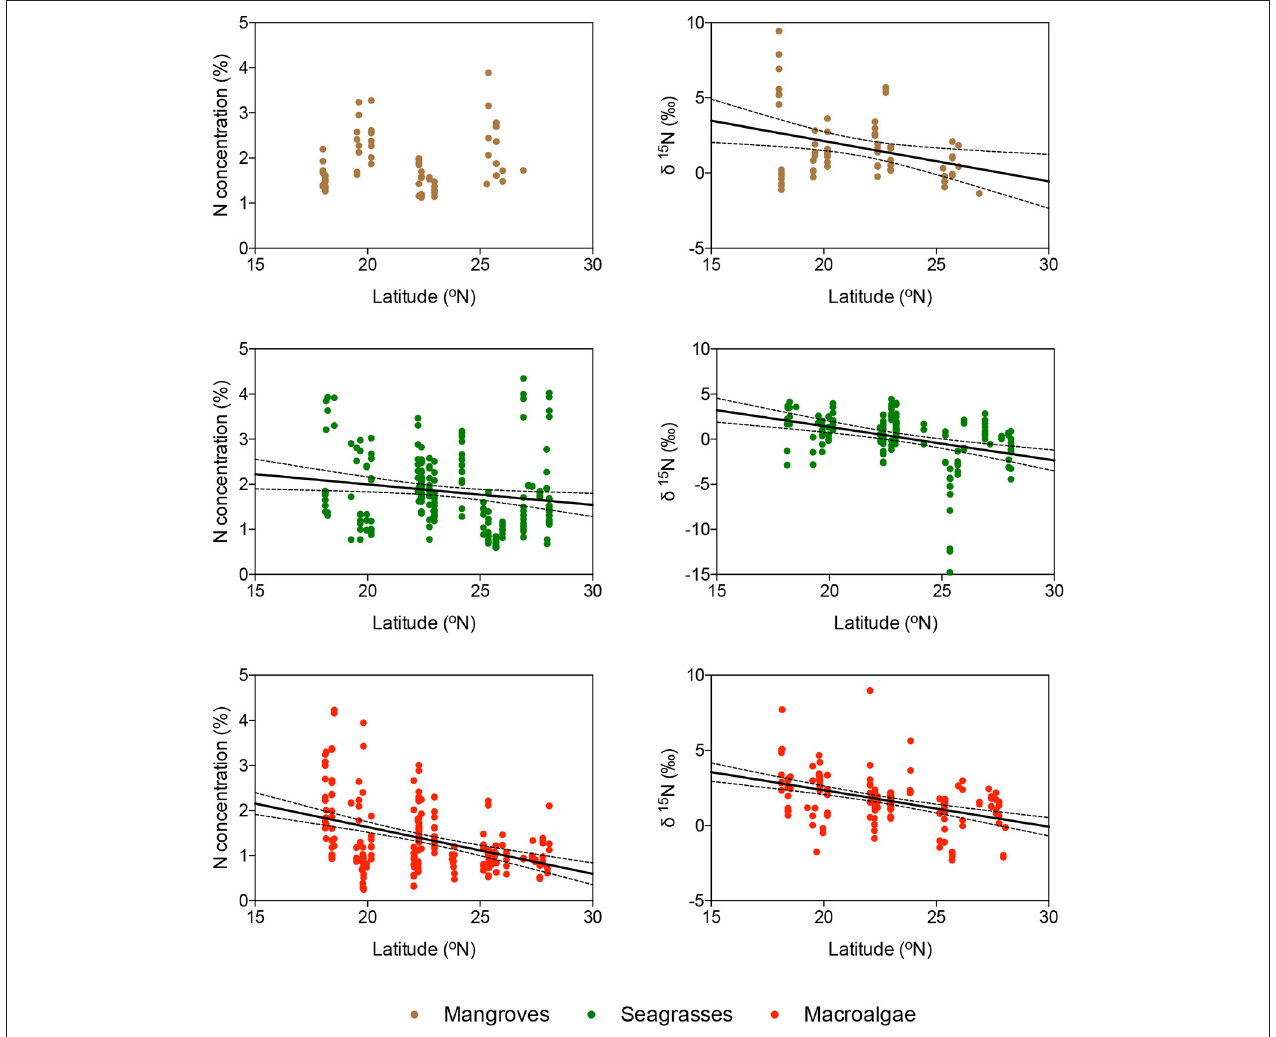
FIGURE 4 | Relationship between latitude and the concentration of nitrogen (panels on the left) and the δ 15 N composition (panels on the right) of the blades of (from top to bottom) mangroves, seagrasses, and macroalgae, indicated in brown, green, and red, respectively. Solid lines show the fitted linear regression equations and dotted lines show the 95% c.l. of the slope. Only significant regressions are